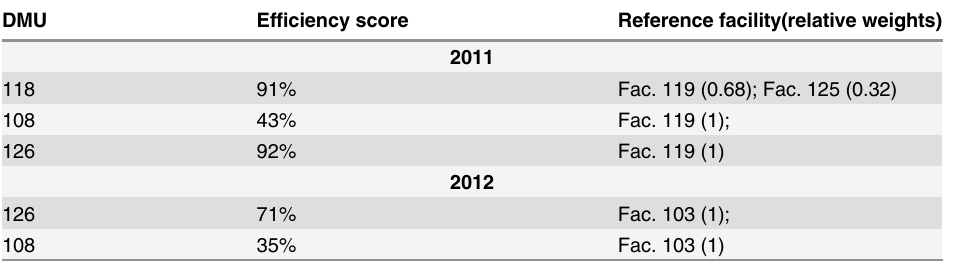
Table 6. Revised DEA model results after deleting low quality facilities: inef fi cient units, their corresponding ef fi ciency reference sets and relative weight respectively assigned to each. DMU Ef fi ciency score